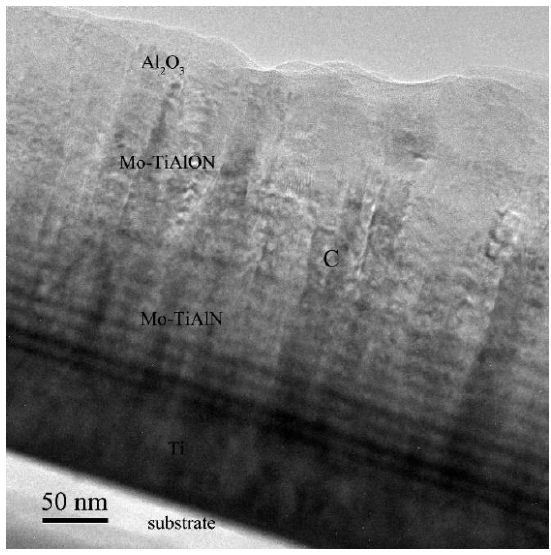
Figure 10. Cross-sectional TEM image of TiMoAlON film with Mo content of 3 at%.